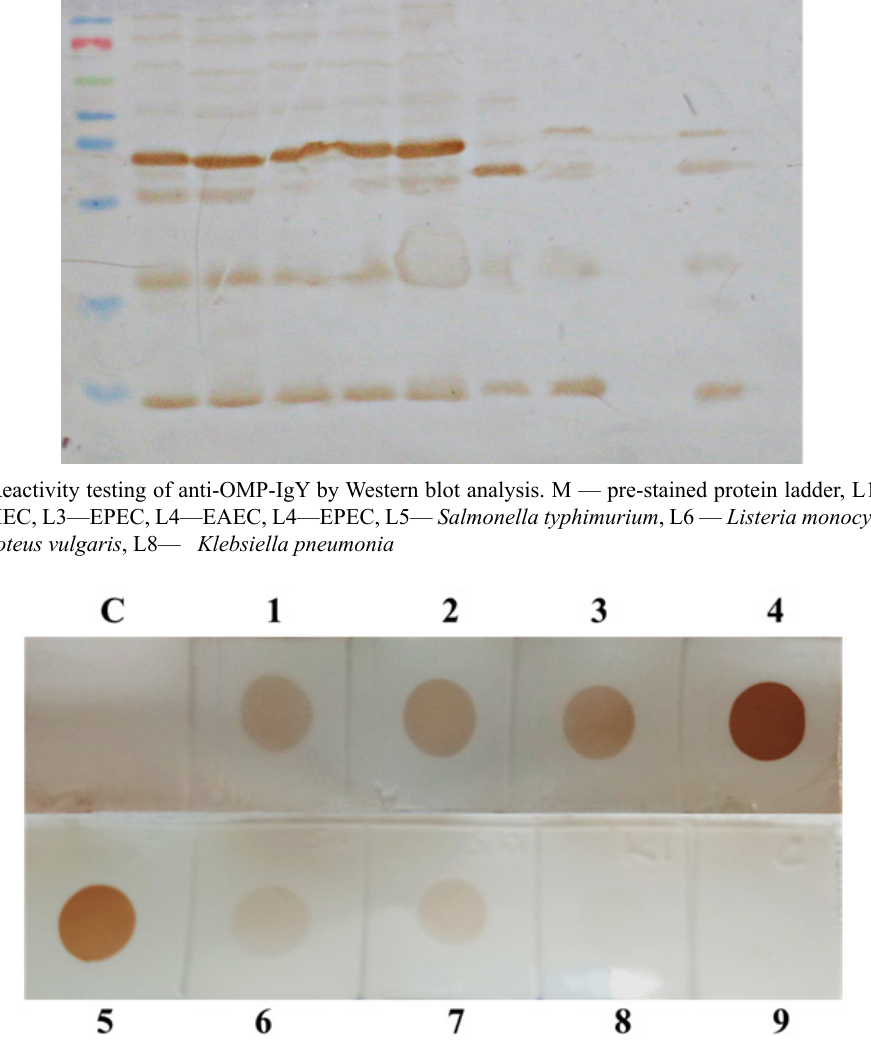
Fig. 2. Reactivity testing of anti-OMP-IgY by dot-ELISA. C-Control, 1- EIEC, 2- EAEC, 3-ETEC , 4-EPEC , 5- EHEC instead of EAEC , 6- Salmonella typhimurium , 7- Klebsiella pneumonia , 8- Listeria monocytogenes